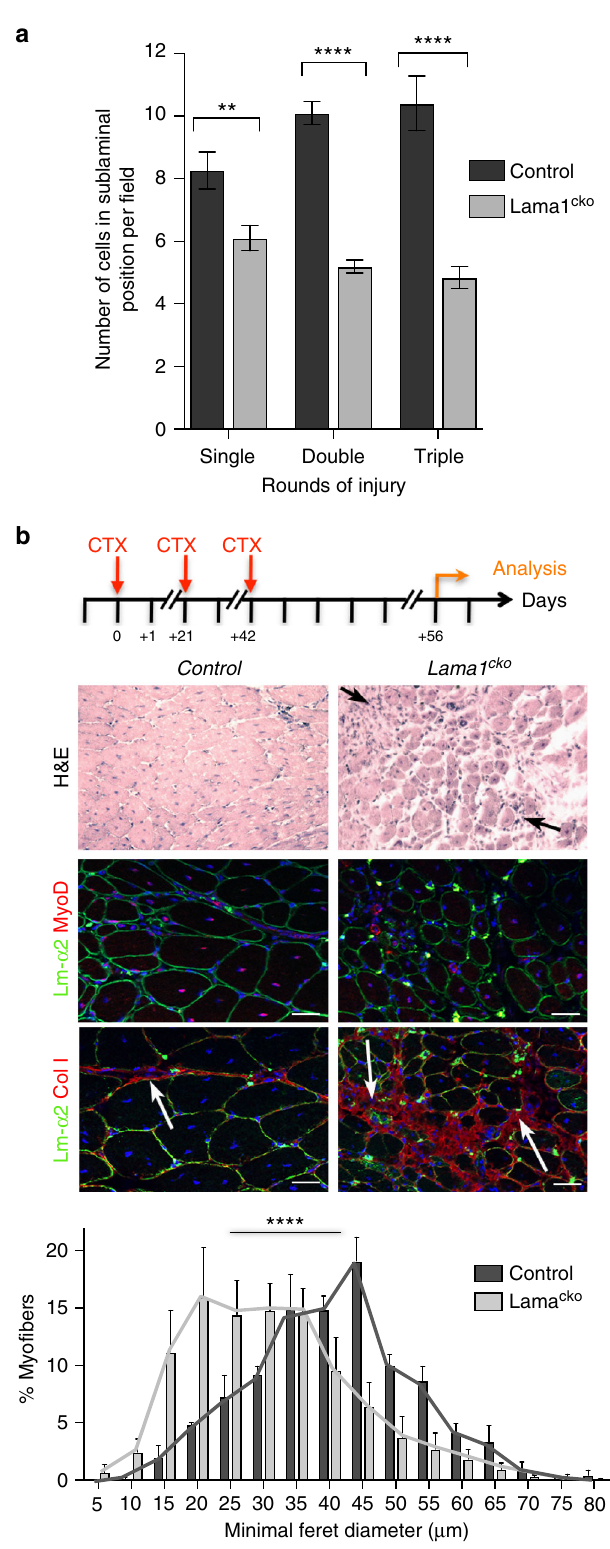
Fig. 5 Impaired long-term regenerative capacity in Lama1 -de fi cient mice. a Number of satellite cells returning to a sublaminal position in regenerated myo fi bers after one round ( n = 3), two rounds ( n = 3), and three rounds ( n = 3) of injury. b Control and Lama1 cko mice analyzed at 14 dpi following three rounds of repeated injuries at 21-day intervals analyzed by Haematoxylin and Eosin staining and immuno fl uorescence for MyoD and collagen I (red). Black arrows indicate the presence of in fi ltrating in fl ammatory cells in Lama1 cko mice. White arrows indicate the site of fi brosis. The graph shows the minimal Feret diameter analysis of control and Lama1 cko mice after 3 rounds of injury. Scale bar, 50 μ m. n = 6 ( Lama1 cko ) and n = 3 (control). Graphs show mean + sem. * P < 0.05, ** P < 0.01, *** P < 0.001, **** P < 0.0001 ( t -test for a and one-way ANOVA for b